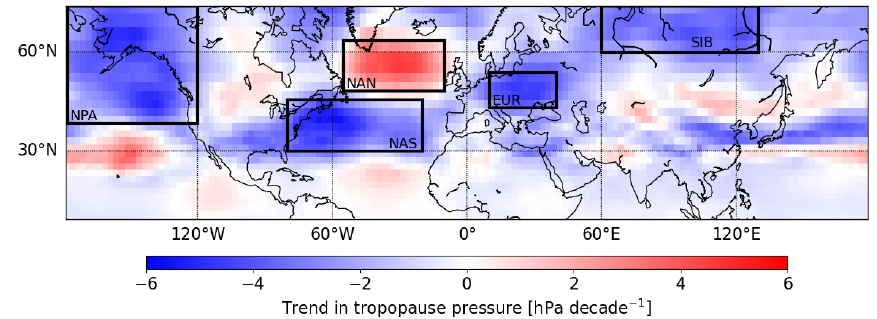
Figure 5. Linear trend for 1997–2020 in tropopause pressure (hPa per decade) derived from the NCEP/NCAR (National Center for Atmo- spheric Research) reanalysis data. Black rectangles signify five regions for which we provide the mean and maximum trends in Table 3. These regions are the northern Pacific (NPA), the northern part of the North Atlantic (NAN), the southern part of the North Atlantic (NAS), Europe (EUR), and Siberia